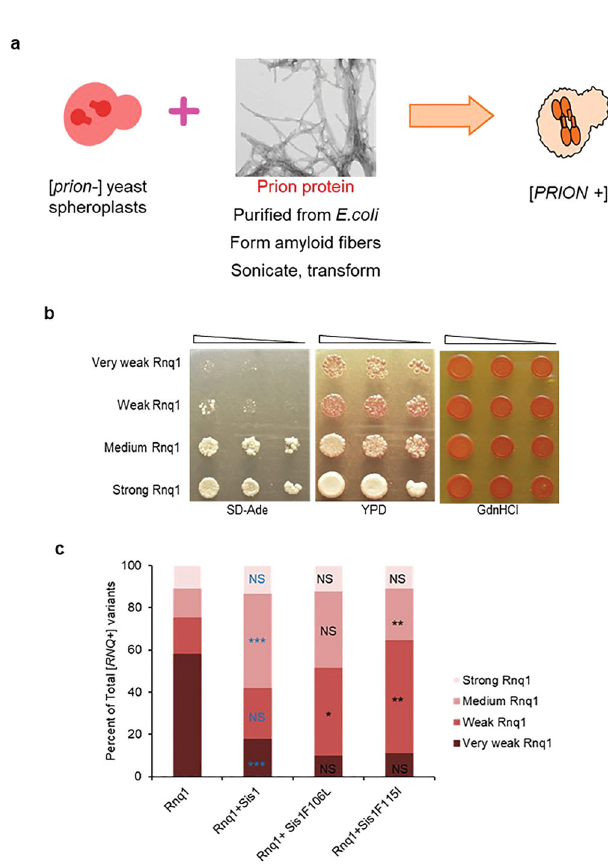
Fig. 2 | Phenotypic distribution of [ RNQ +] strain alters with LGMDD1 G/F domain mutants. a Cartoon showing transformation of Rnq1 amyloid fi bers formed at 18°C into [ prion -/ rnq − ] 74-D694 yeast cells induces strains of the [ PRION +/ RNQ +] prion. RRP was used to assess [ RNQ +] phenotype. [ RNQ +] prion strains co-aggregate with RRP and cause different phenotypes; colony color on YPD and growth on SD-ade medium are indicative of different levels of sup- pression of the ade1-14 premature stop codon to produce Ade1 and represent different [ RNQ +] strains. Curability by growth and color on medium containing GdnHCl was used to determine prion-dependence of phenotypes. The transfor- mants from fi ve separate experiments for each sample set were picked and >200 colonies for each set were scored as very weak, weak, medium, or strong [ RNQ +] b and graphed for statistical analysis c . In panel c , the blue color indicates the comparison between Rnq1 (alone) and Rnq1 with Sis1-WT; NS=0.197 for strong [ RNQ +], *** p <0.00023 for medium [ RNQ +], NS=0.357 for weak [ RNQ +], *** p <0.00025 for very weak [ RNQ +]. Black color indicates the comparison between Sis1-WT and LGMDD1 mutants (F106L and F115I); (NS=0.298 and 0.269) for strong [ RNQ +], (NS=0.165 and ** p <0.008) for medium [ RNQ +], (* p <0.022 and** p <0.008)forweak[ RNQ +],(NS=0.231and0.409)forveryweak[ RNQ +]. p - values are reported for unpaired, two-sided t -test. Source data are provided as a Source data fi